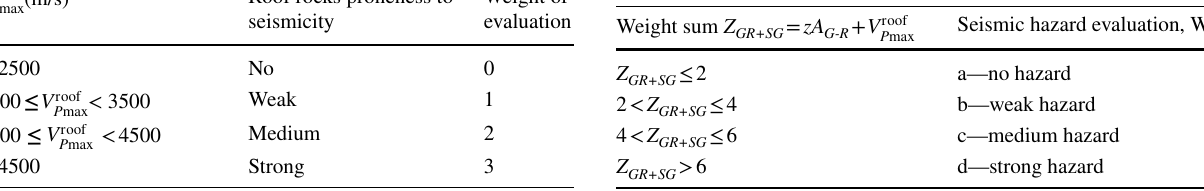
Table 3 Seismic hazard evaluation criteria based on the V roof P max param- eter value Table 4 Seismic hazard evaluation scale based on the comprehensive use of the G-R law and seismic geotomography